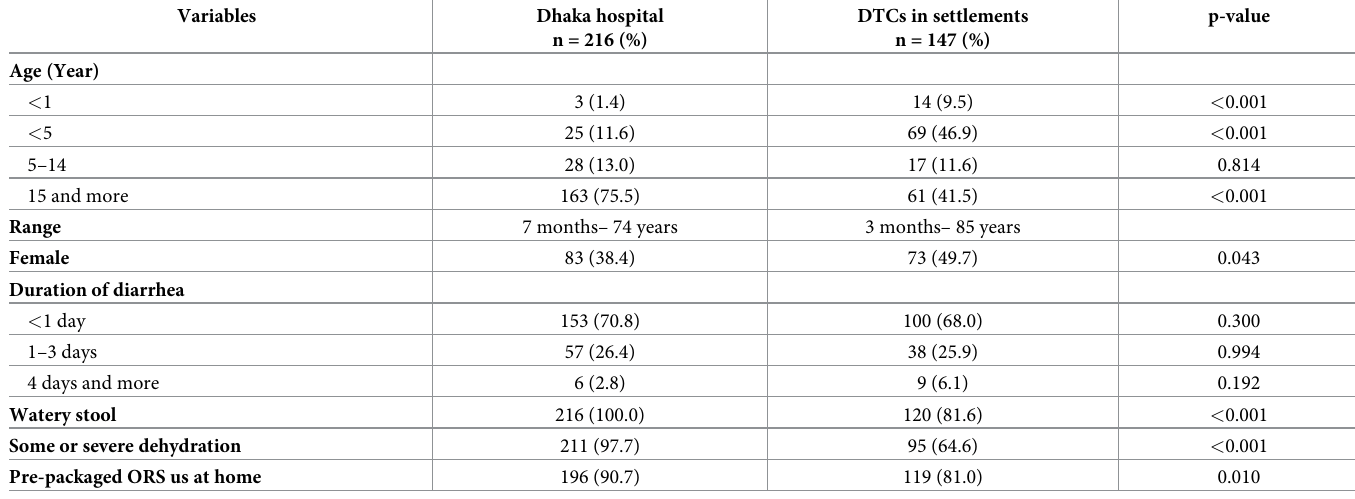
Table 3. Age stratified cholera patients in Dhaka Hospital and DTCs in Cox’s Bazar settlements, September-December 2019.